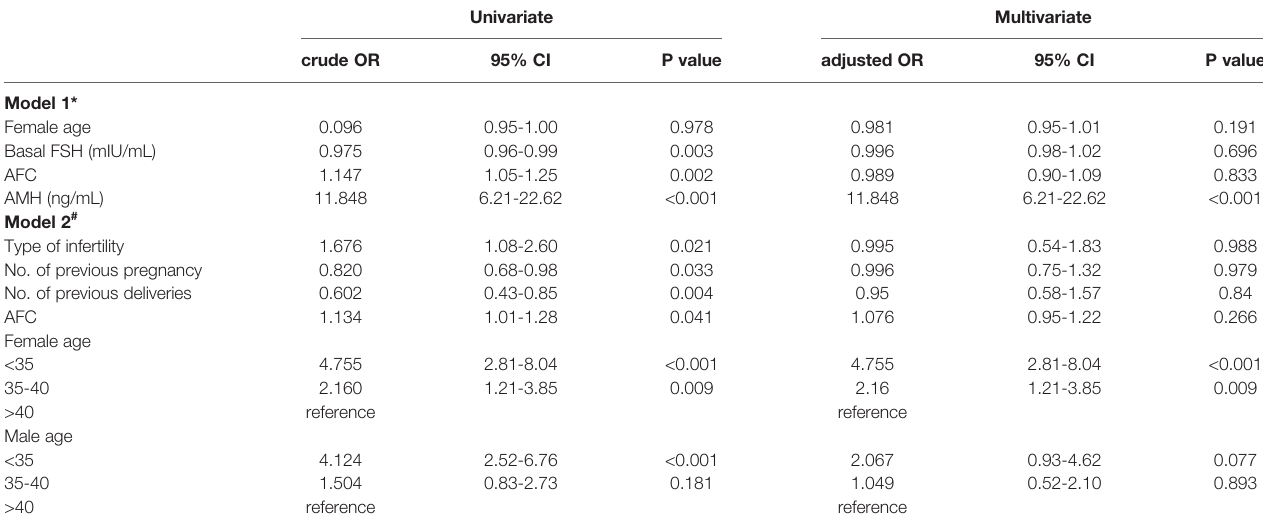
TABLE 3 | Factors associated with reproductive outcomes in women with DOR.